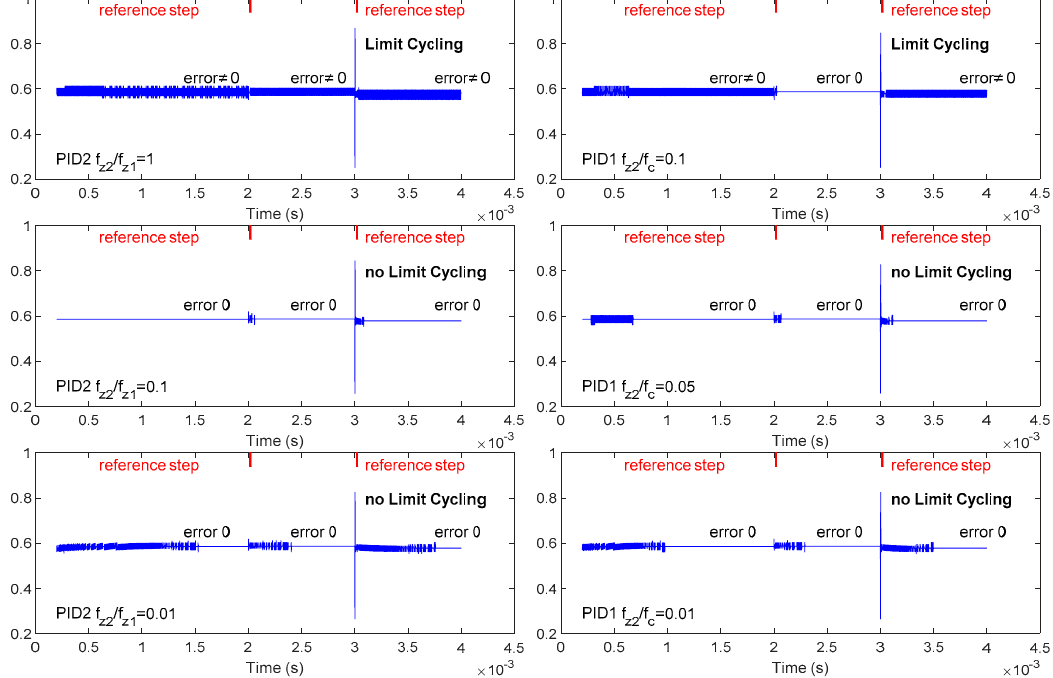
Figure 10. Time response to reference steps for different compensators corresponding to design A (Figure 8). A limit cycle exists for PID1 f z 2 / f z 1 = 1 and PID2 f z 2 / f c = 0.1, as predicted by the performance space.